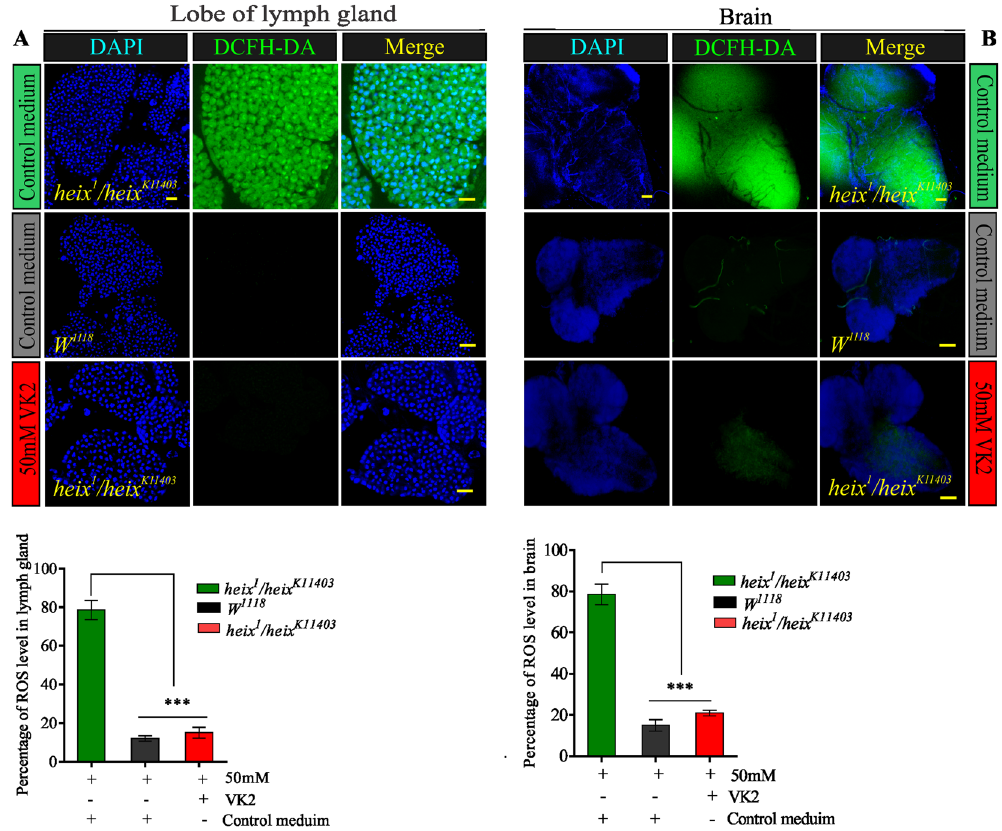
Figure 2. Vitamin K2 lowers ROS release. ( A ) Confocal microscopy showed increased ROS in Lymph gland of heix mutants, reduced by VK2 treatment. ( B ) Confocal microscopy showed increased ROS in Brain of heix mutants, reduced by VK2 treatment. Both lesions responded significantly to treatment. DAPI stain (blue) and ROS staining (CM-H2DCFDA) (green). Control media contain 50 mM Ethanol (EtOH) and treatment media contain 50 mM VK2. Means normalized to control ( Canton S ). Error bars indicate SEM. Analysis of variance (AVOVA/Dunnett: * P < 0.05, ** P < 0.01, *** P <